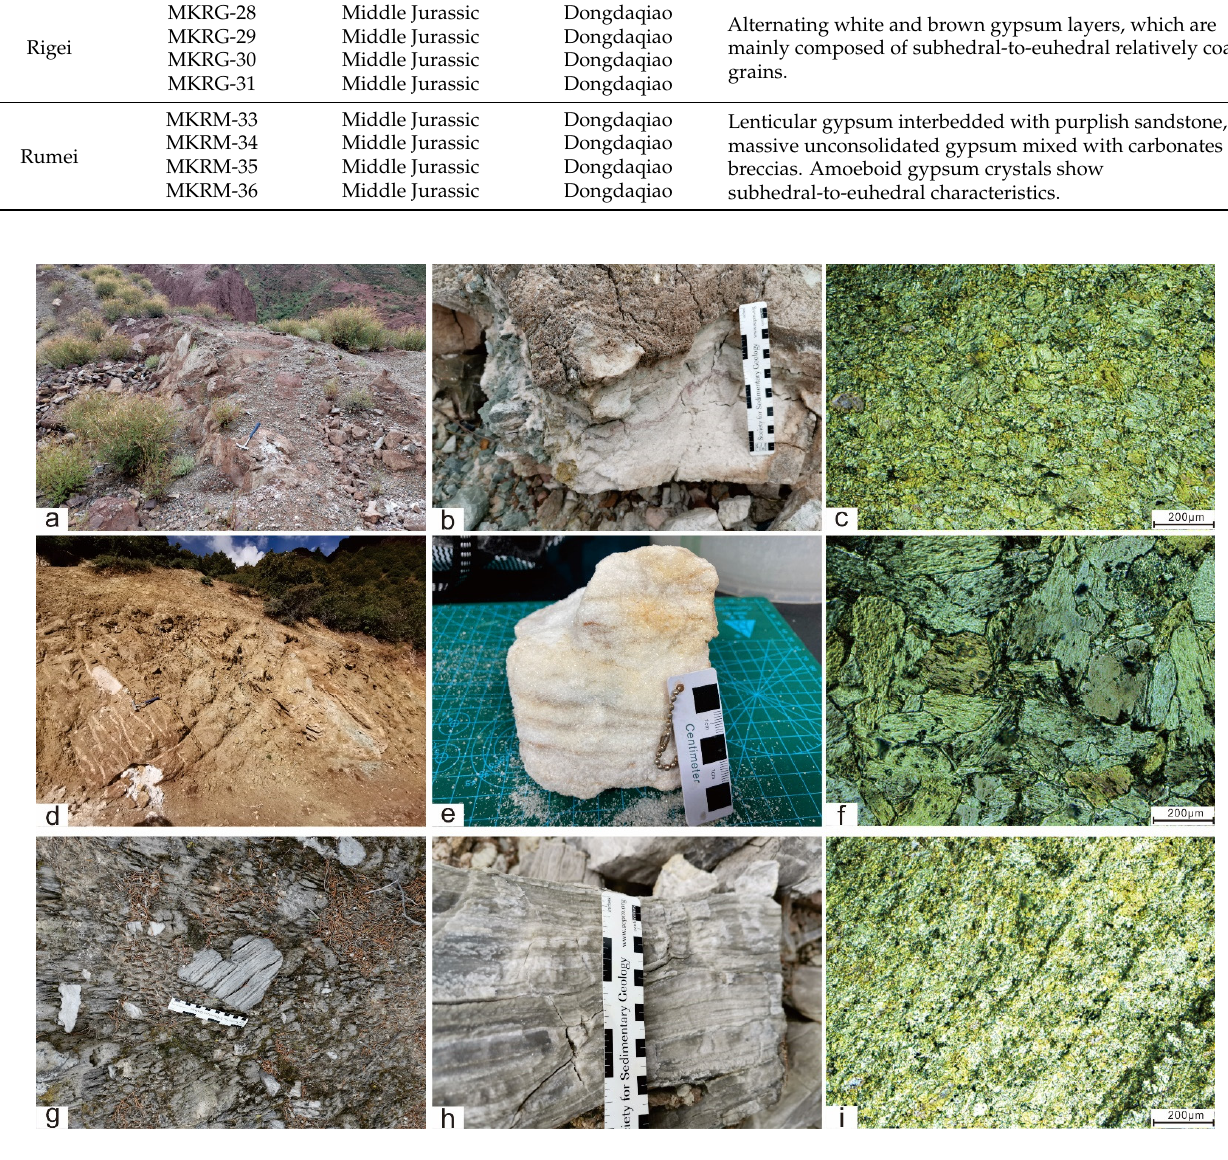
Figure 4. Characteristics of the Middle Jurassic evaporites in the Qamdo Basin. ( a ) lenticular gypsum interbedded with purplish sandstone, Rumei; ( b ) unconsolidated gypsum mixed with carbonate breccia, Rumei; ( c ) subhedral, amoeboid gypsum crystals, Rumei, cross-polarised light (CPL); ( d ) bedded gypsum intercalated with brown siltsone, Rigei; ( e ) centimetre-scale gypsum layers characterised by the number of detrital components, Rigei, CPL; ( f ) subhedral to euhedral gypsum crystals, ~100–500 μ m, Rigei; ( g ) millimetre-scale gypsum layers with corroded surfaces, Huola; ( h ) gypsum laminae, Huola; and ( i ) aligned gypsum fibres, Huola, CPL. Table 1. Description of Middle Jurassic sulphates from the Qamdo Basin.